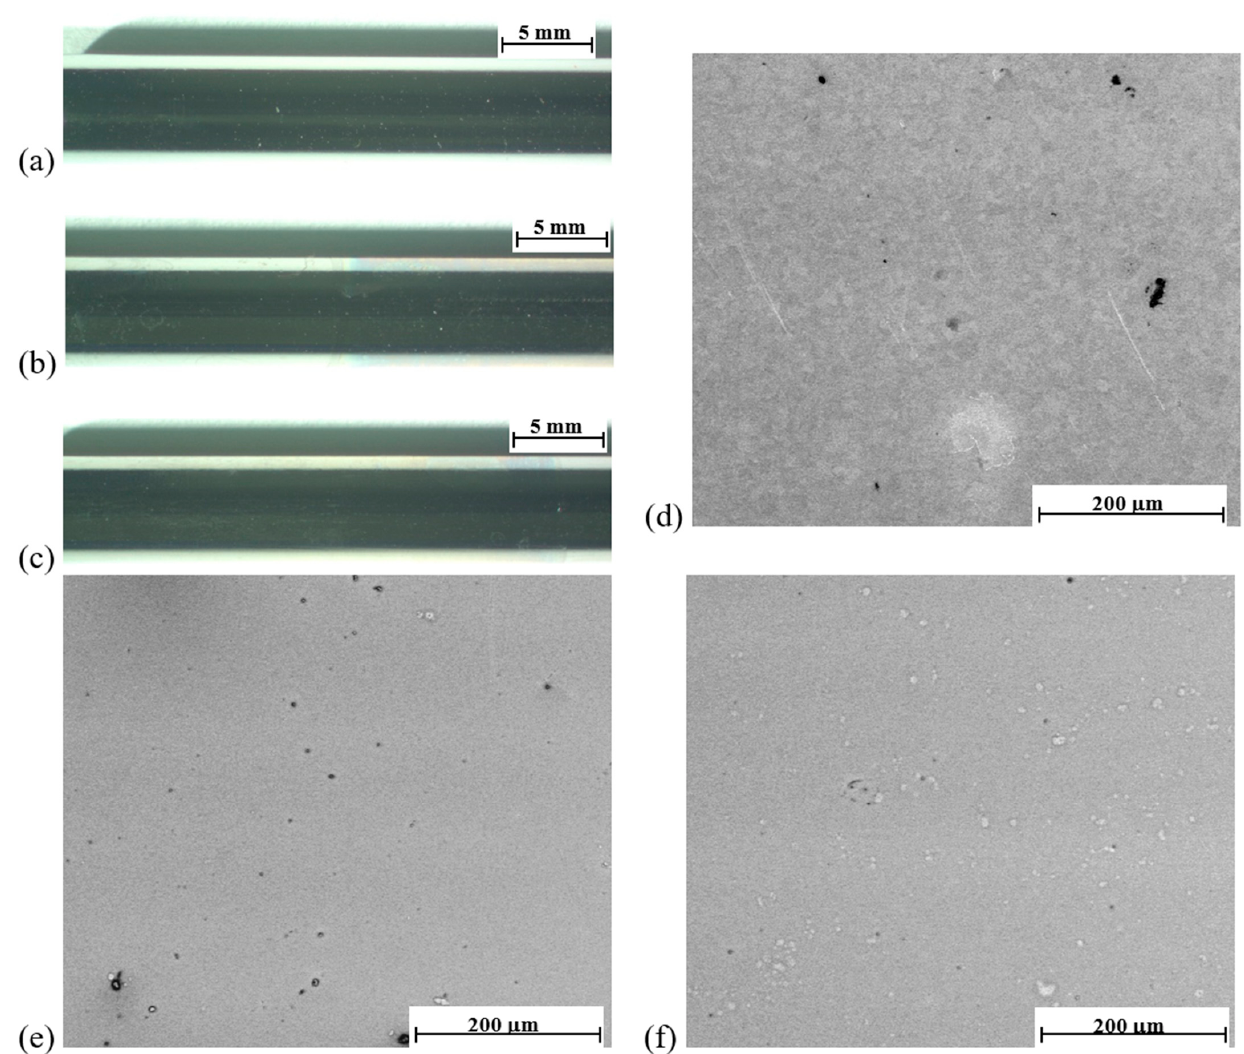
Figure 1. Observations of the samples’ surfaces in the initial state. Stereoscopic microscope of cylinder-shaped samples. ( a ) Electropolished surface; ( b ) electropolished with P(L,L-L/CL) + PVA + HEP coatings; ( c ) electropolished with P(D,L-L/CL) + PVA + HEP coatings. Scanning microscope of samples in the shape of discs. ( d ) Electrolytic polished surface; ( e ) electropolished with P(L,L-L/CL) + PVA + HEP coatings; ( f ) electropolished with P(D,L-L/CL) + PVA + HEP coatings.